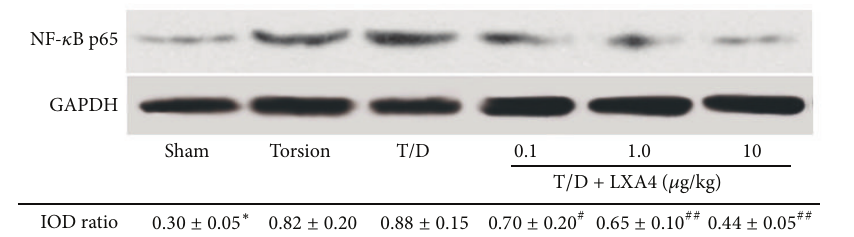
Figure 3: Western-blot for NF- 𝜅 B p65 expression in testicular tissue. NF- 𝜅 B p65 expression was increased after testicular torsion in both torsion and torsion/detorsion (T/D) groups. However, the NF- 𝜅 B p65 expression has been inhibited by LXA4 treatments. Compared with other groups, ∗ 𝑃 < 0.05 . Compared with T/D group, # 𝑃 < 0.05 and ## 𝑃 < 0.01